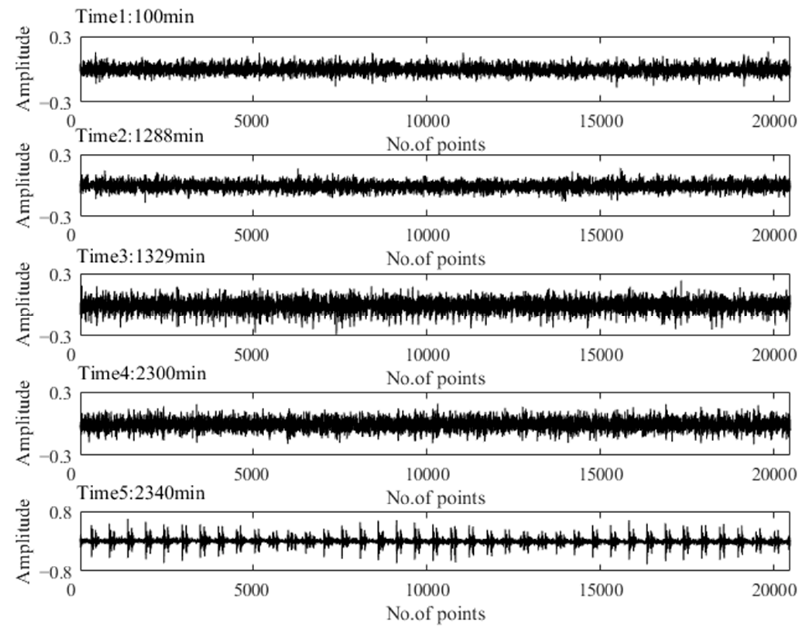
Figure 10. Time plots of five representative moments .